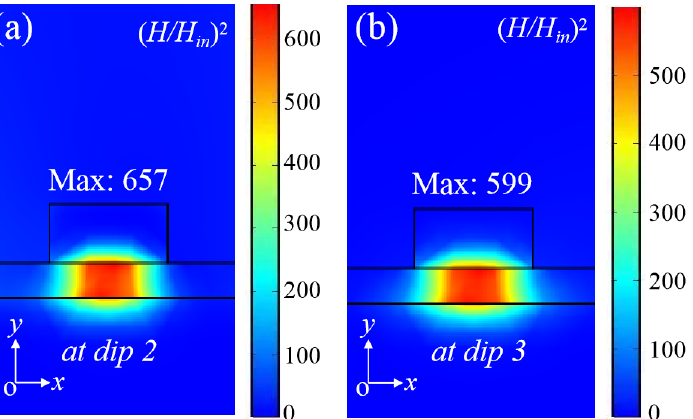
Figure 3. and The intensity distributions of normalized magnetic field ( H / H in ) 2 on the xoy plane for the dip 2 ( a ) and dip 3 ( b ) resonances. The boundaries of different materials are shown by the black solid lines.